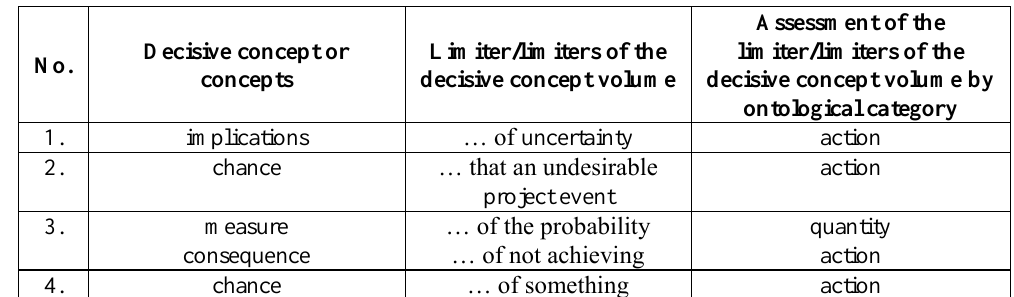
Table 2. Information about the